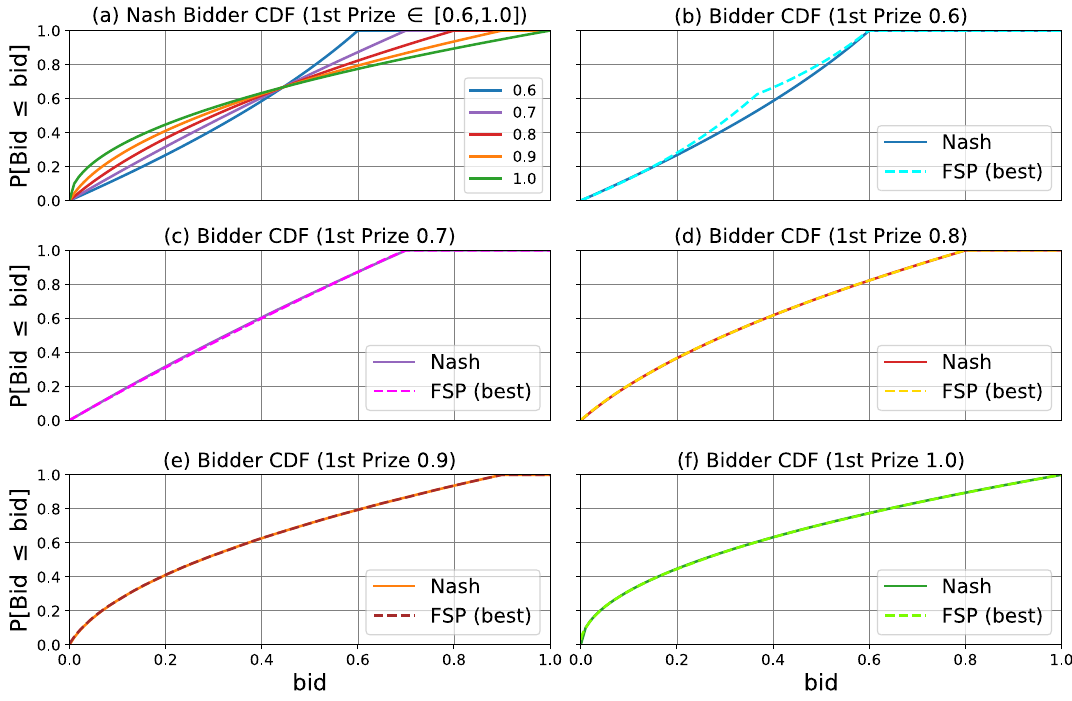
Figure 3. Bidding strategy CDFs. ( a ) shows the CDFs for each of five different contest designs assuming the bidder plays the Nash distribution. The first prize is listed in the legend; the second prize equals one minus the first; no prize is given to the third bidder. The remaining plots ( b – f ) compare the Nash CDF with the CDF learned by Fictitious Self-Play for different first prize amounts.